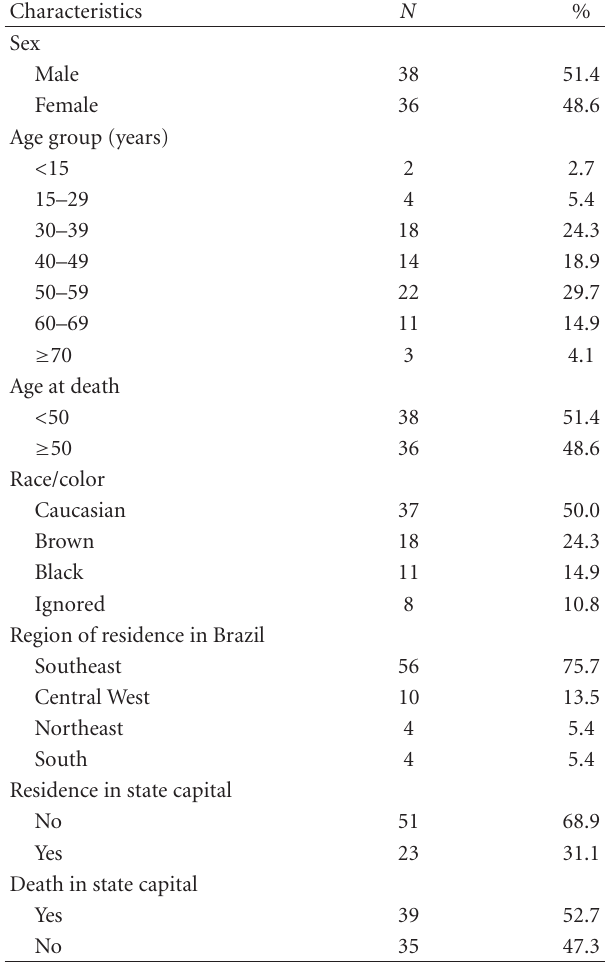
Table 1: Sociodemographic characteristics of deaths related to Chagas disease and HIV/AIDS co-infection in Brazil, from 1999 to 2007 ( n =